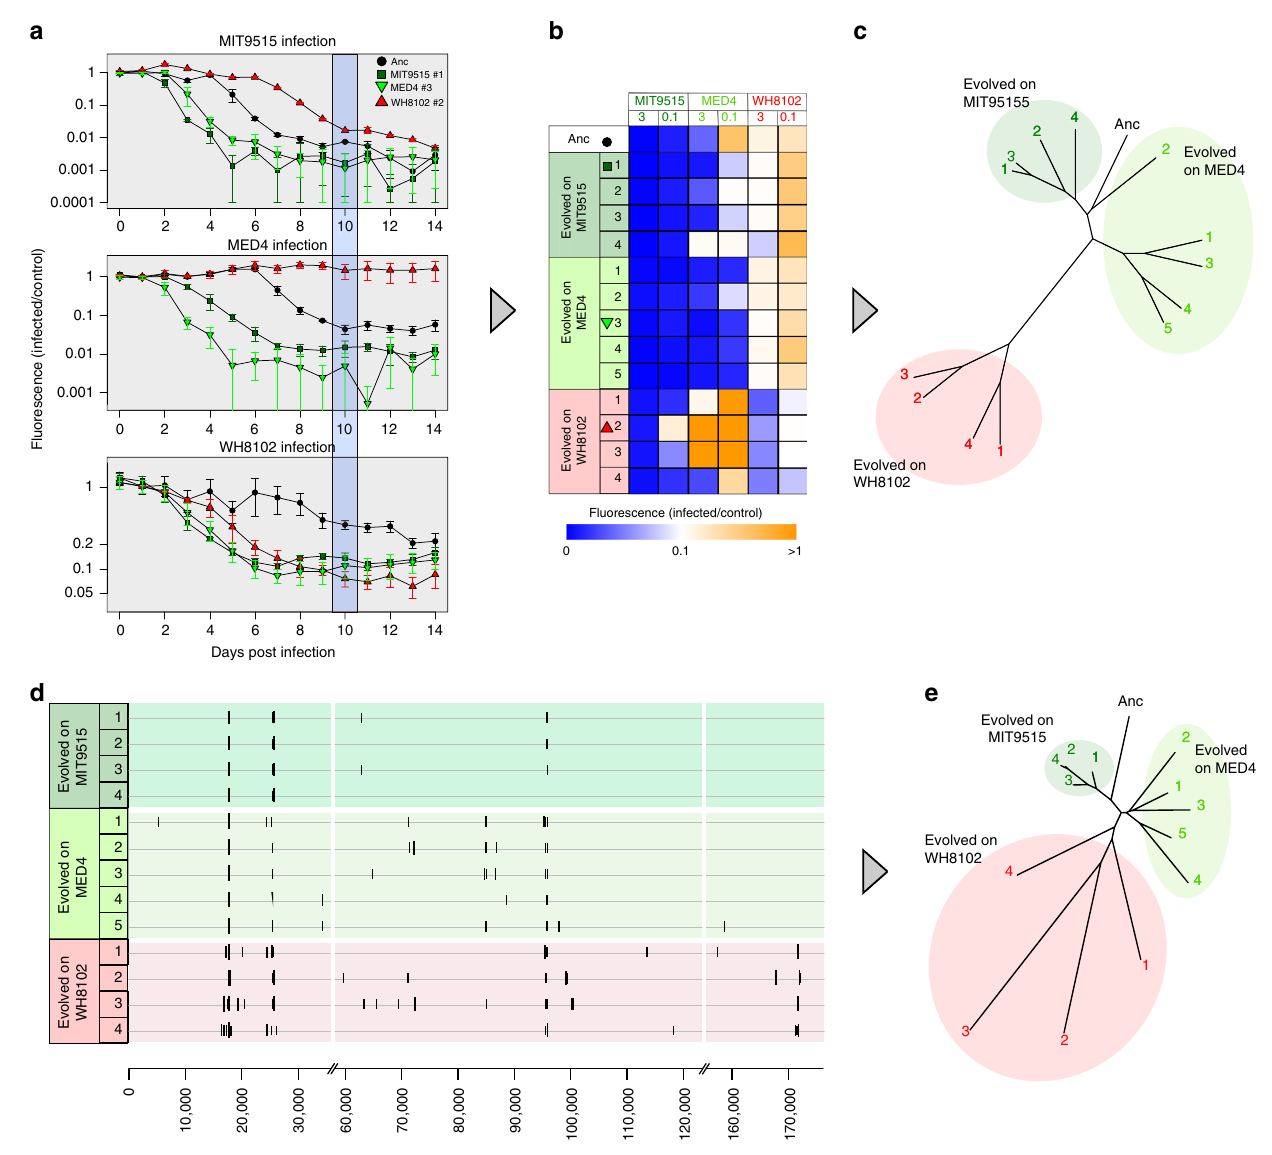
Fig. 3 Phage populations adapted to the same host show high within-group similarity. a Representative normalized growth curves of the three hosts when infected by four phage populations at a virus particle per cell ratio of 3. Phage populations shown are the ancestral (Anc), evolved in the optimal host (MIT9515 #1), and evolved in sub-optimal hosts (MED4 #3, WH8102 #2). Y -axis shows the fl uorescence levels of infected cultures divided by the fl uorescence of the uninfected culture, i.e, normalized culture fl uorescence. Blue shading shows normalized fl uorescence on the tenth day post infection, which was used for further analyses. Each curve is the average of three infection assays, error bars correspond to standard deviations. b Normalized cell densities of all infected cyanobacterial cultures at 10 days post infection. Lower values indicate more rapid declines in the infected host population, i.e. increased fi tness (Supplementary Figure 1). Rows correspond to viral populations, columns are for infections of speci fi c hosts at 0.1 and 3 viral particles/ cell. Each box is the average of three infection assays. Symbols next to the population number denote the populations shown in panel a . c The phenotypic distance tree is based on the infection pro fi le of each population (i.e., values of each row in panel b ). Colors and numbering correspond to panel b . d Genomic maps show increased diversity in populations evolved in sub-optimal hosts. Positions along the genome are shown on the x- axis; horizontal lines correspond to speci fi c populations. Vertical lines correspond to identi fi ed mutations, and their length corresponds to the mutation frequency within the population. e Genotypic distance tree reveals lower distance in populations evolved in MIT9515. The tree was constructed based on pair-wise genetic distances between phage populations. Colors and numbering correspond to panel b . Raw data can be found in Supplementary Table 2 and